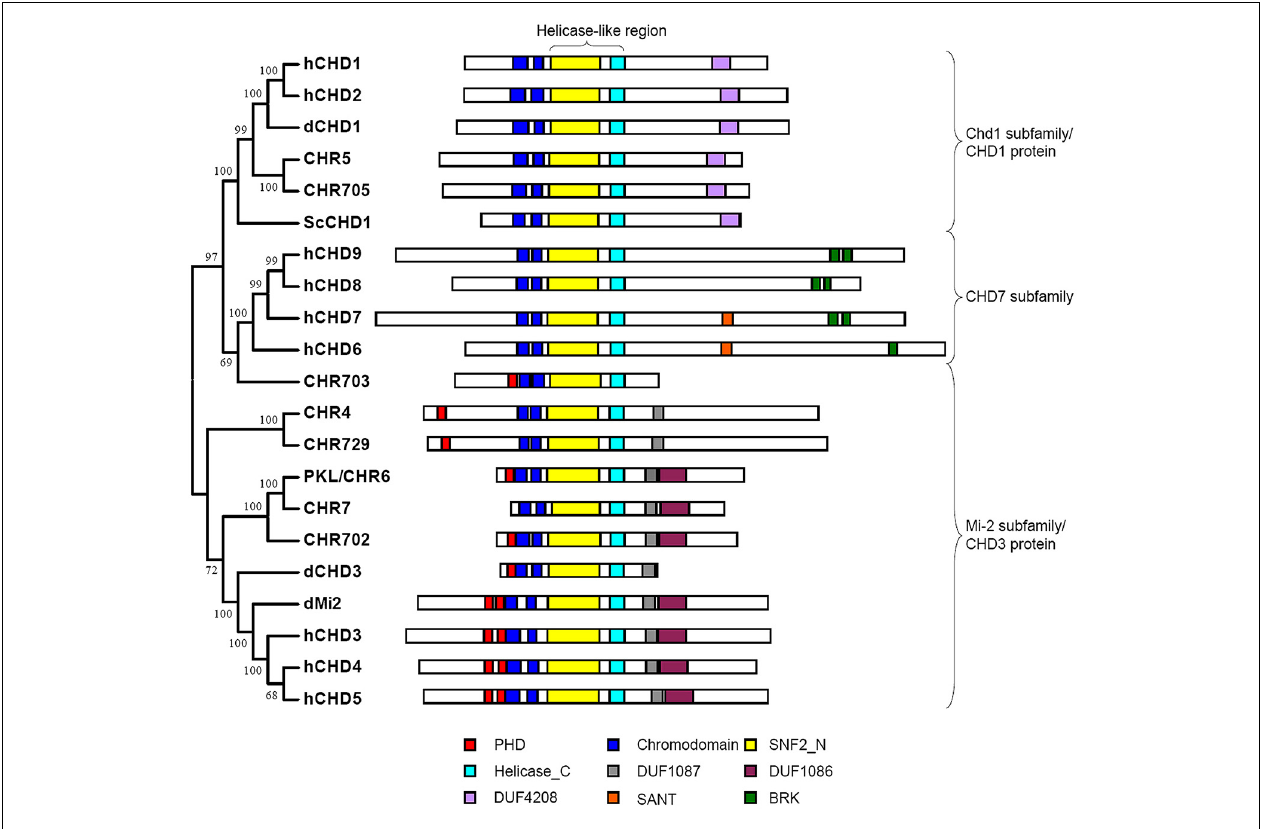
FIGURE 1 | Structural domain of CHD proteins. Conserved domains of CHD proteins in yeast (Sc), fly (d), human (h), Arabidopsis (CHR4, CHR5, CHR6 and CHR7) and rice (CHR702, CHR703, CHR705 and CHR729) are represented by rectangle with different